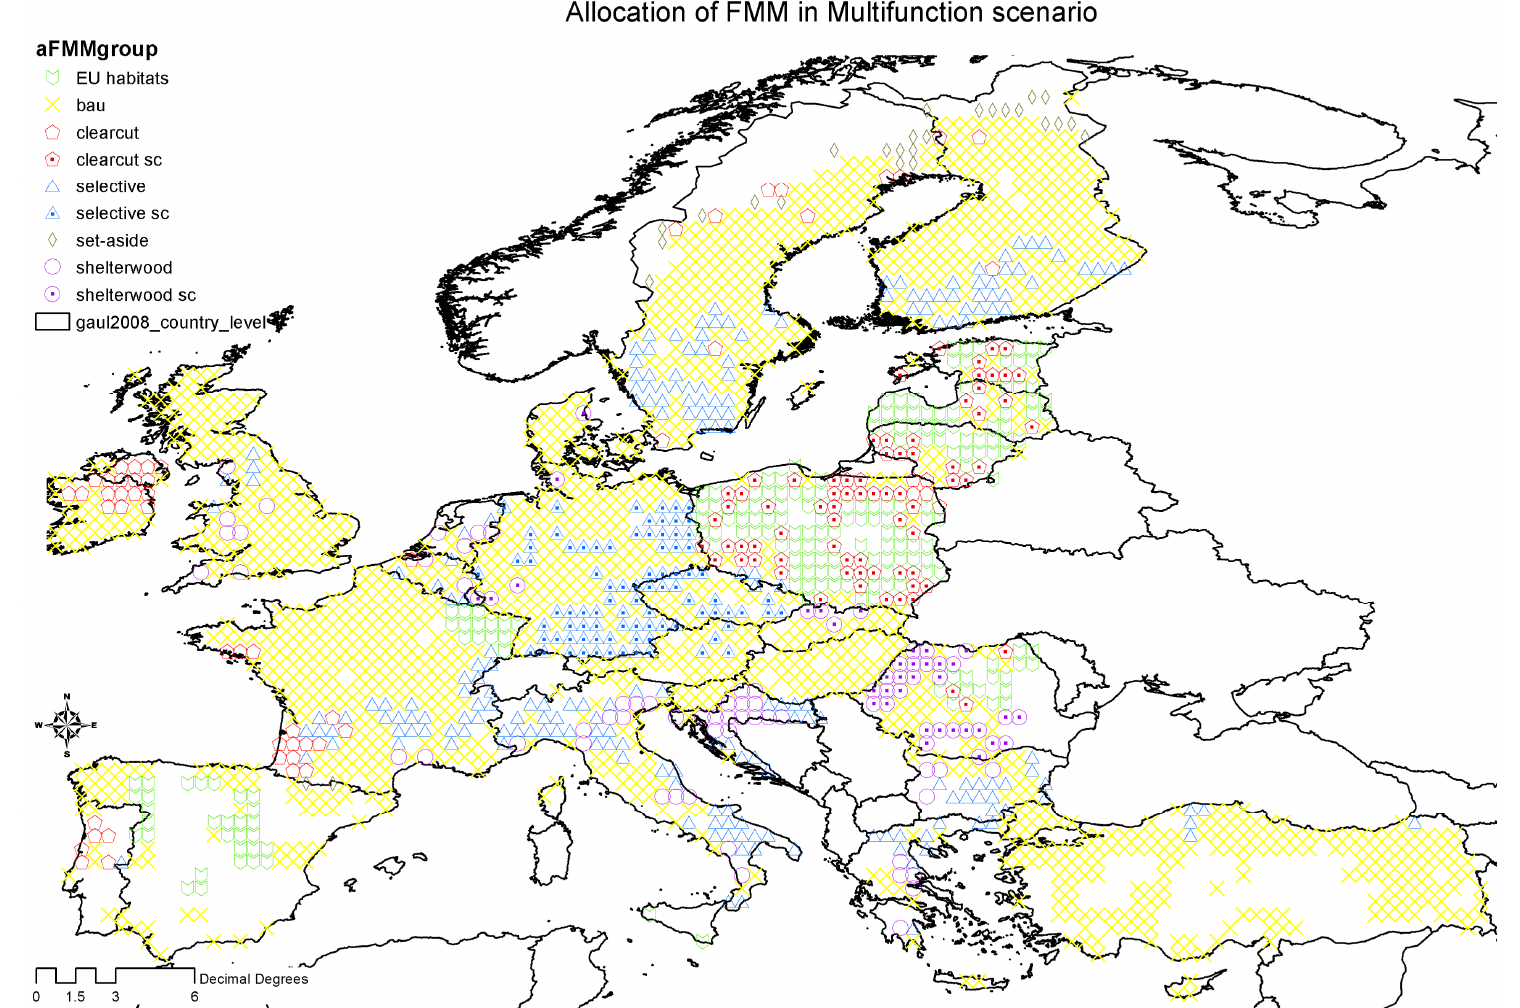
Figure A2. Allocation of the forest management models in the multifunction